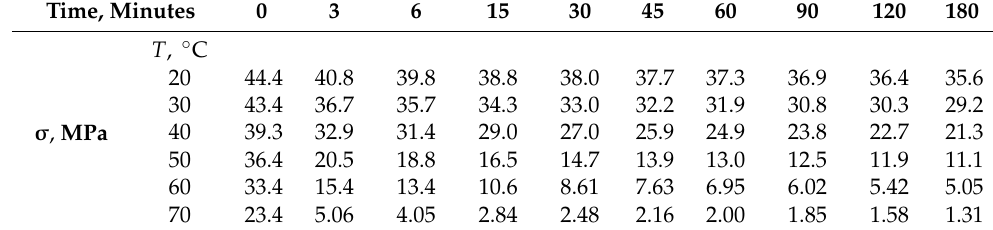
Figure 4. Neural net training performance graph.